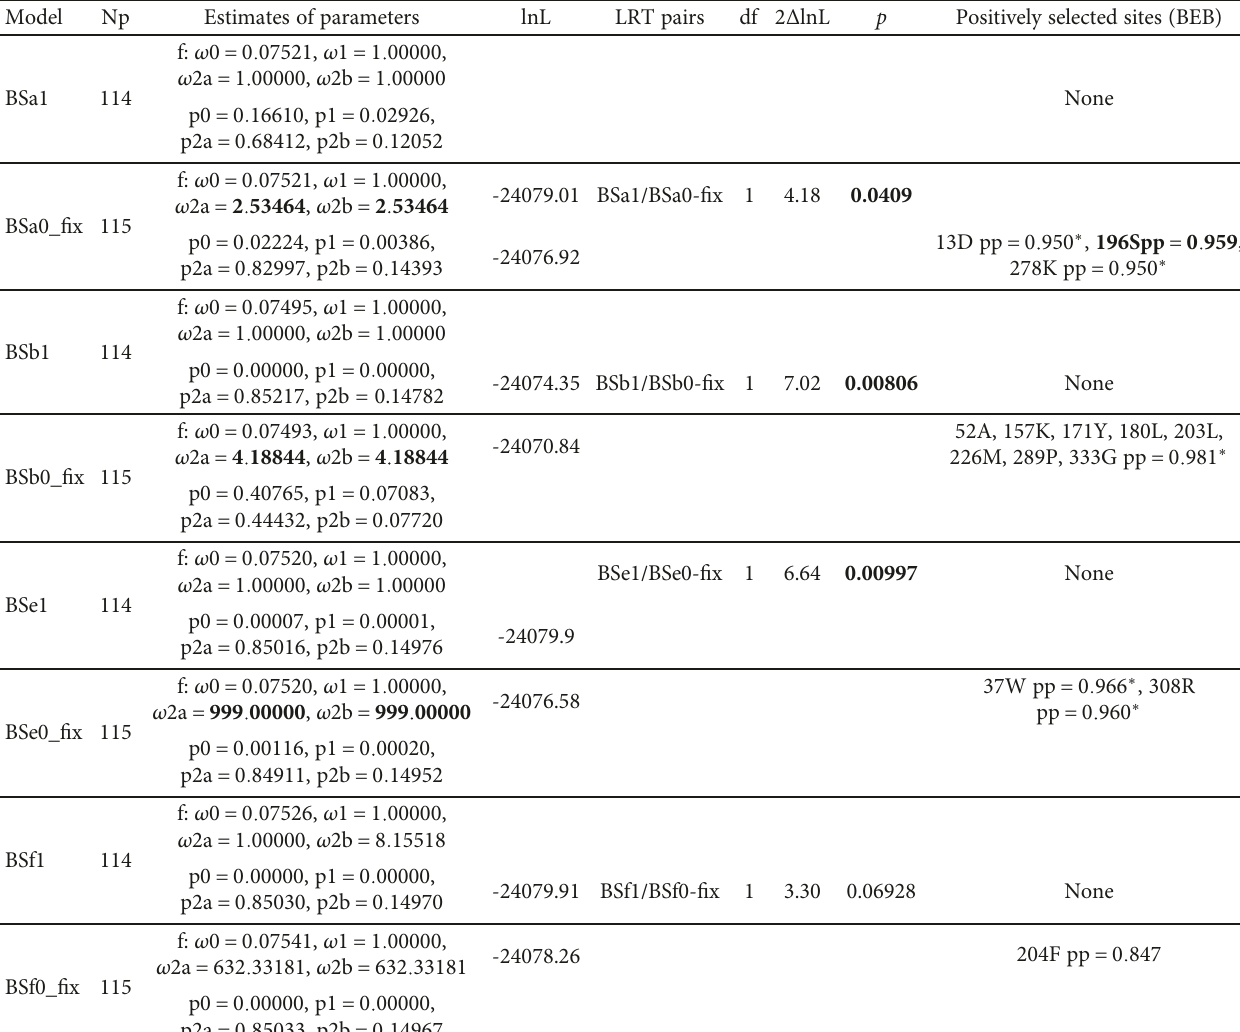
Table 5: Parameter estimation and likelihood ratio tests for the branch-site